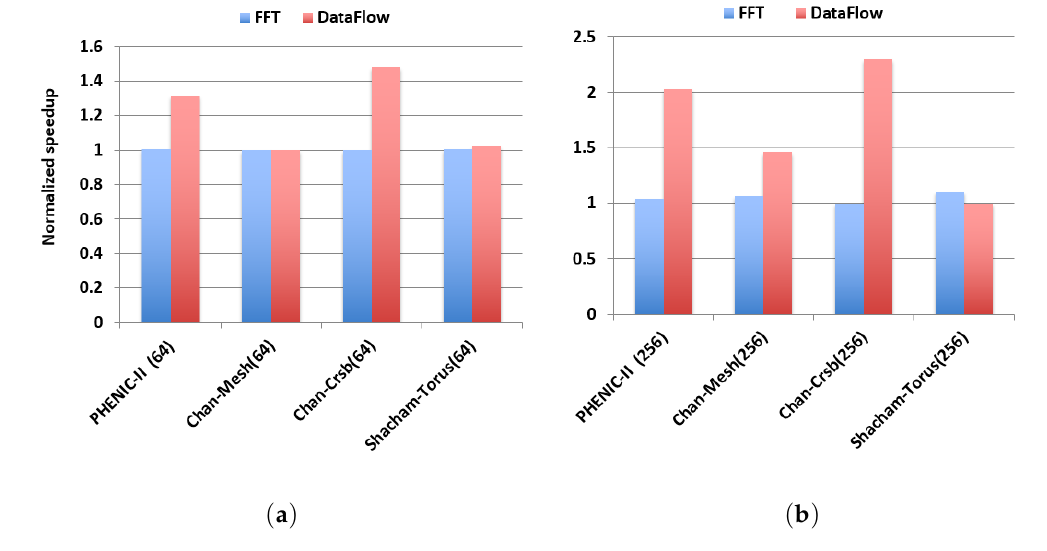
Figure 16. Normalized speedup comparison results: ( a ) 64 cores; ( b ) 256